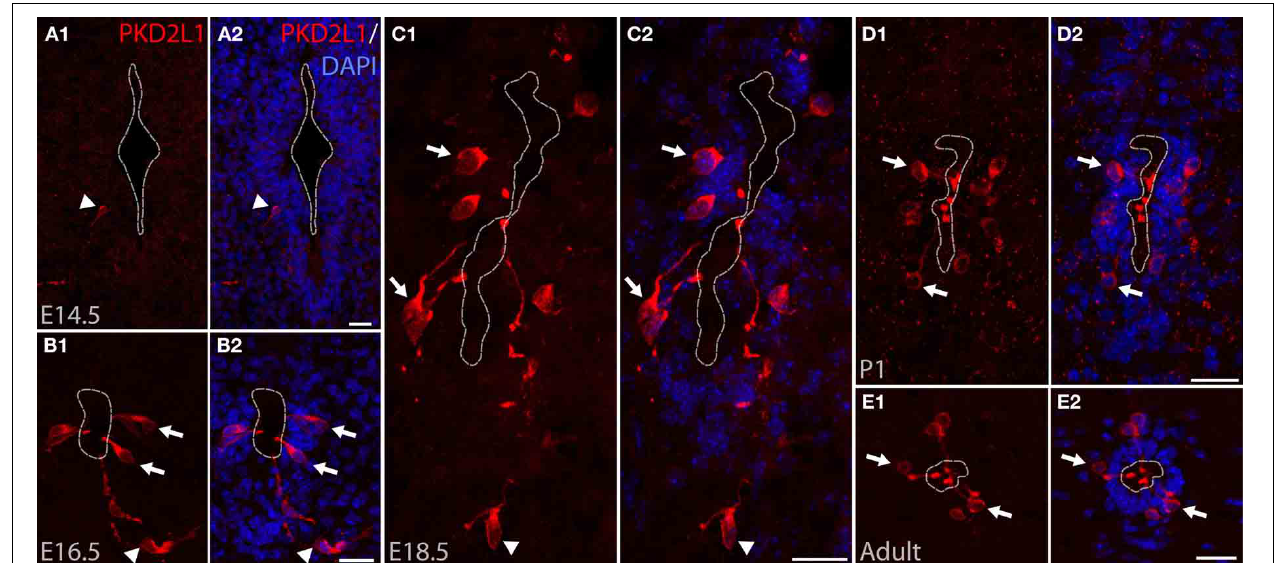
(arrows) surround the central canal where they project an apical bulbous dendritic extension contacting its lumen. Note that PKD2L1 + cells exhibiting a similar morphology but not distinctly contacting the central canal (arrowheads) can also be observed (A–C) . Dorsal is up. White dashed line delineates the central canal. DAPI staining appears in blue. Scale bars = 20 μ m.